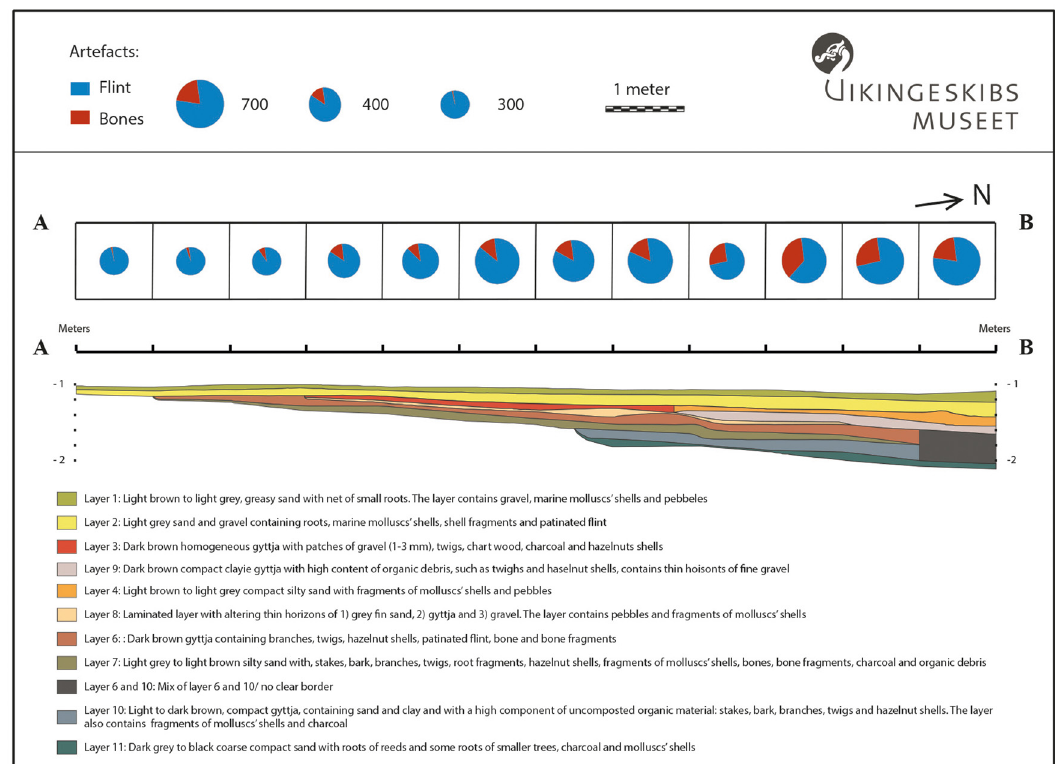
Figure 7: Orenæs, Kabel 8 , site plan and pro fi